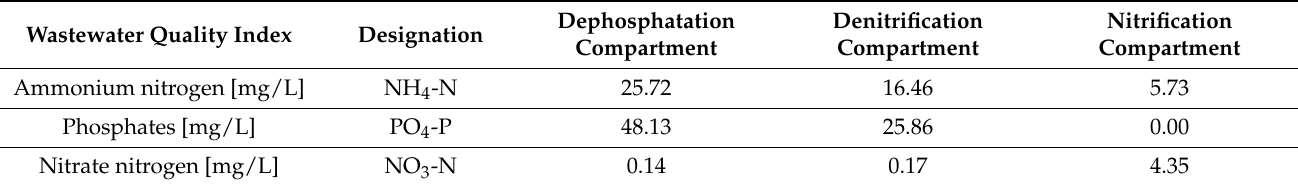
Table 1. Summary of results obtained for chemical parameters from online measurements for three types of bioreactor compartments in Starachowice.